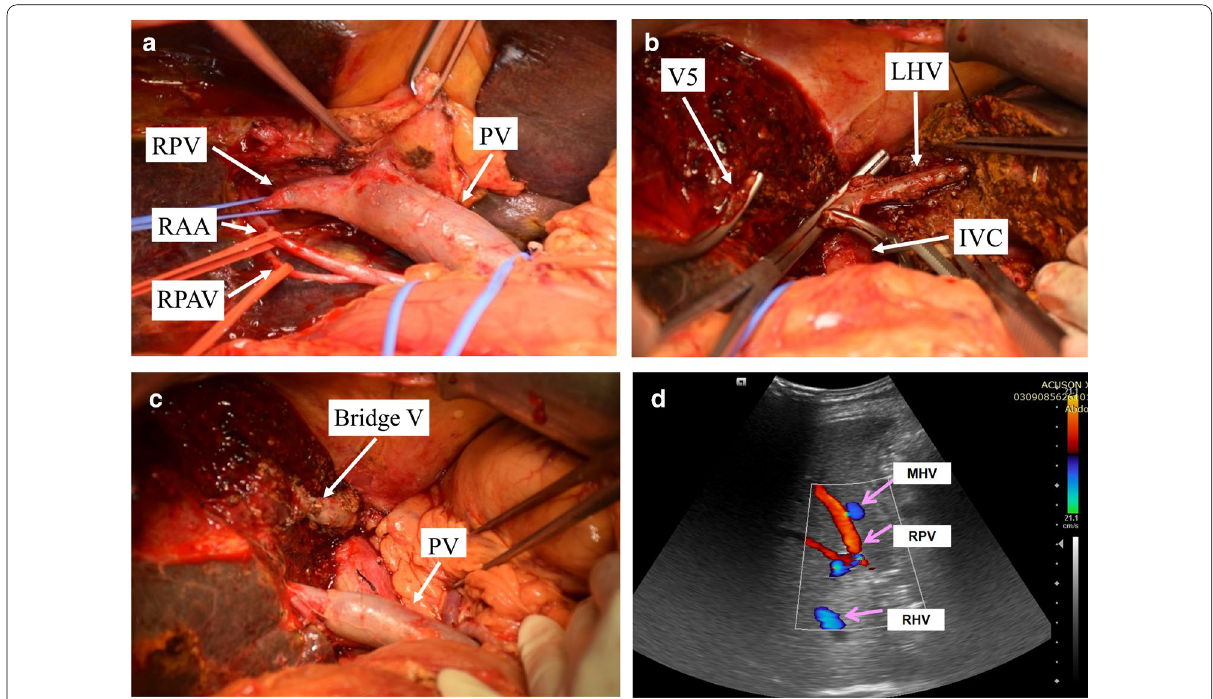
Fig. 7 Intraoperative hepatic vascular management: a skeletonization of right hepatic artery, portal vein. The bifurcation of portal vein was infiltrated by the tumor. b The root of the middle hepatic vein was infiltrated, after dissecting part of left hepatic vein from its root and rotated its direction, the main trunk of the middle hepatic vein was reconstructed with end to end anastomosis. c Reconstruction images of portal vein and hepatic vein. d Ultrasound on postoperative day 60 shows good blood flow in the right branch of the portal vein and middle hepatic vein. RPV right portal vein, PV portal vein, MHV middle hepatic vein, LHV left hepatic vein, RAA right anterior artery, RPA right posterior artery, IVC inferior vena cava, Bridge V bridge